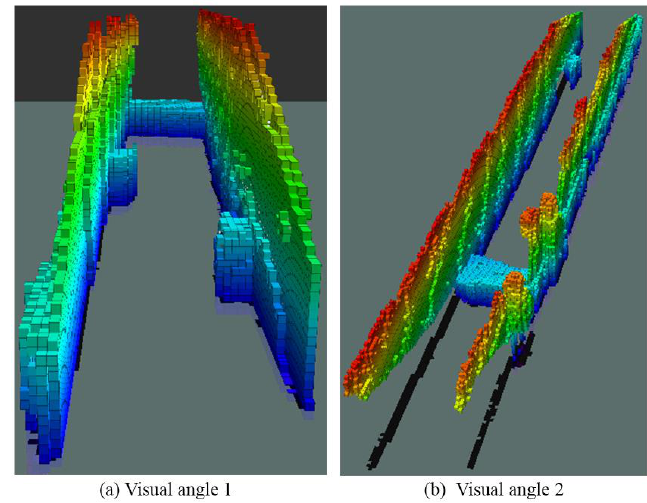
Figure 15. Octree map of simulated roadway.